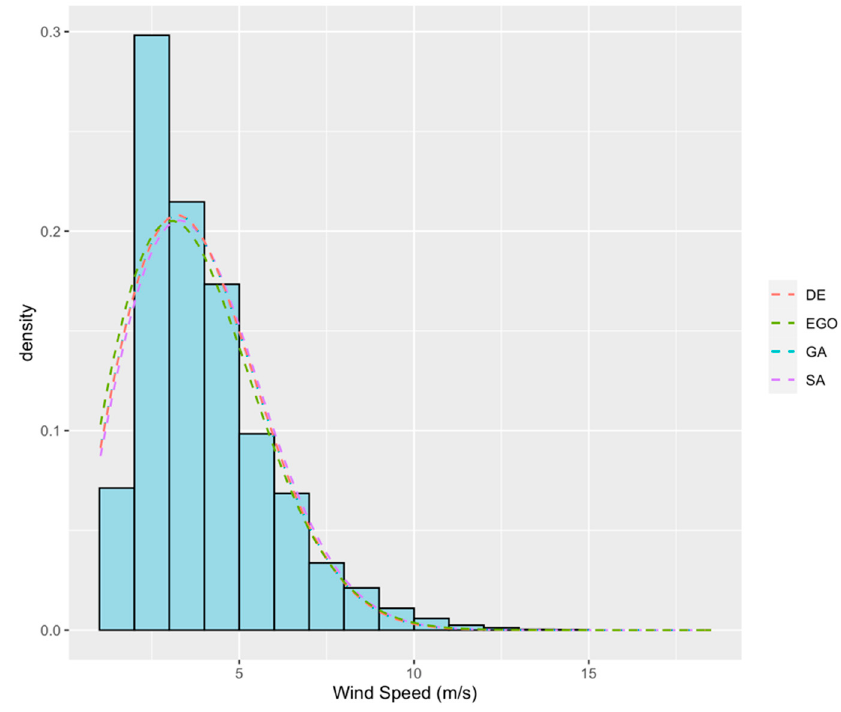
Figure 12. Probability density function estimation and histogram of observed WS for annual data Figure 12. RMSE values for monthly parameter estimation per each technique (own elaboration). (own elaboration). k was estimated as equal to 2.05 and 𝑥̅ is calculated as 3.81. Using Equation (14), wind power density can be calculated and it is equal to 62.89 W/m 2 .